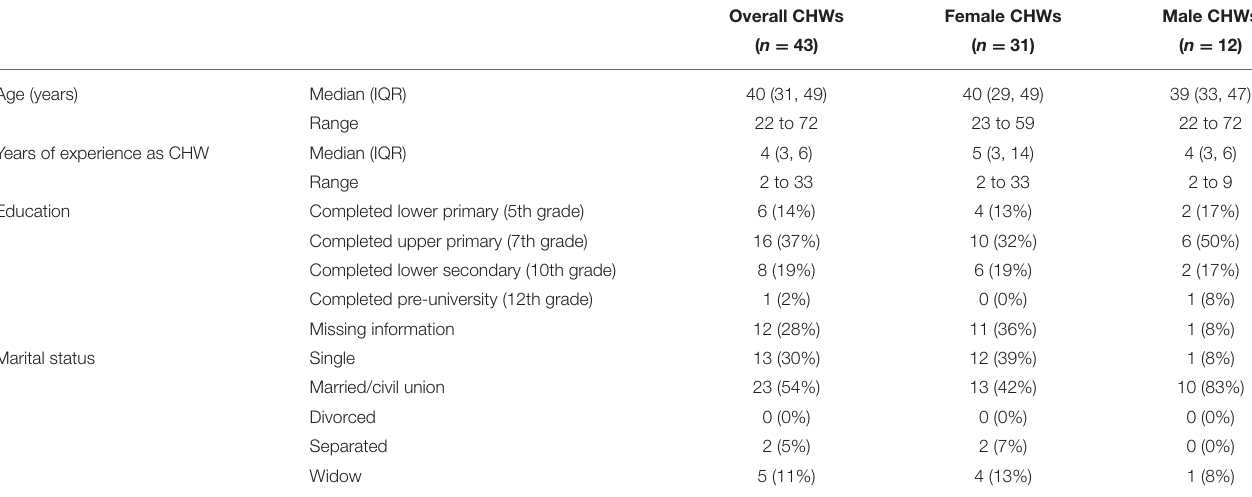
TABLE 1 | Demographic characteristics of CHWs that used POM by